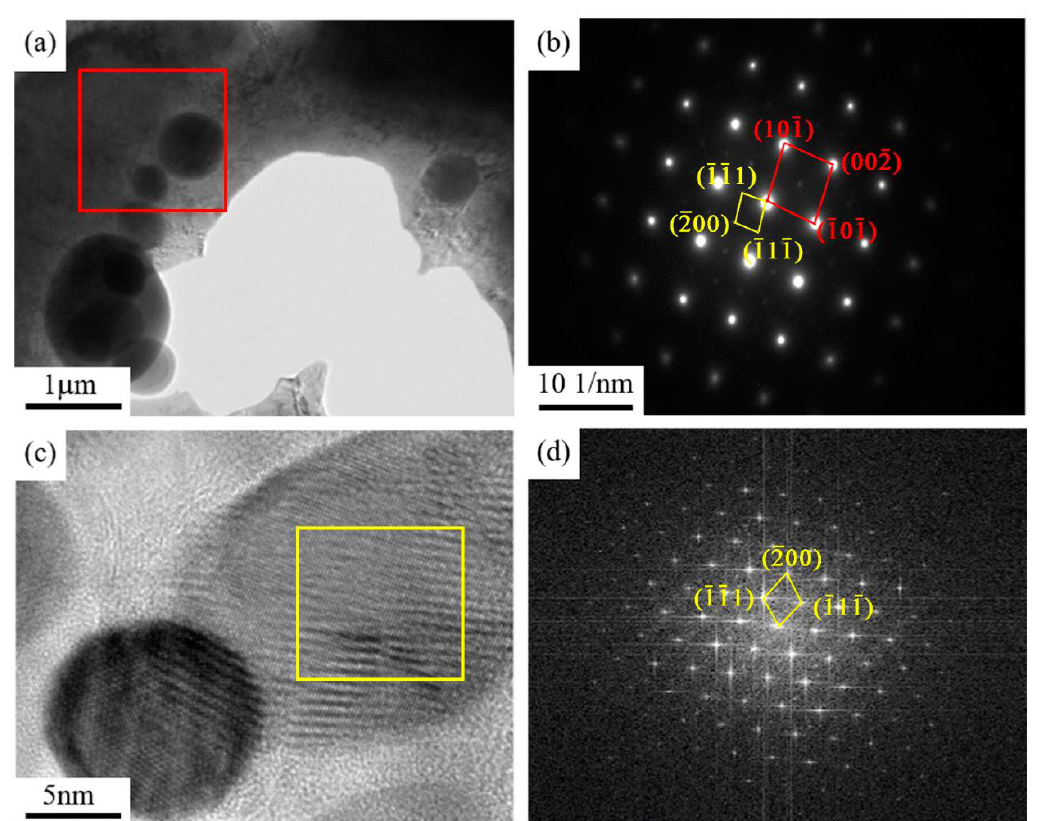
Figure 6. TEM images and analysis of the Cu–6Ni–6Sn–0.6Si alloy: ( a ) bright-field image, ( b ) dark-field image, ( c ) selected- area electron diffraction, ( d ) high-resolution image and Fourier transform.